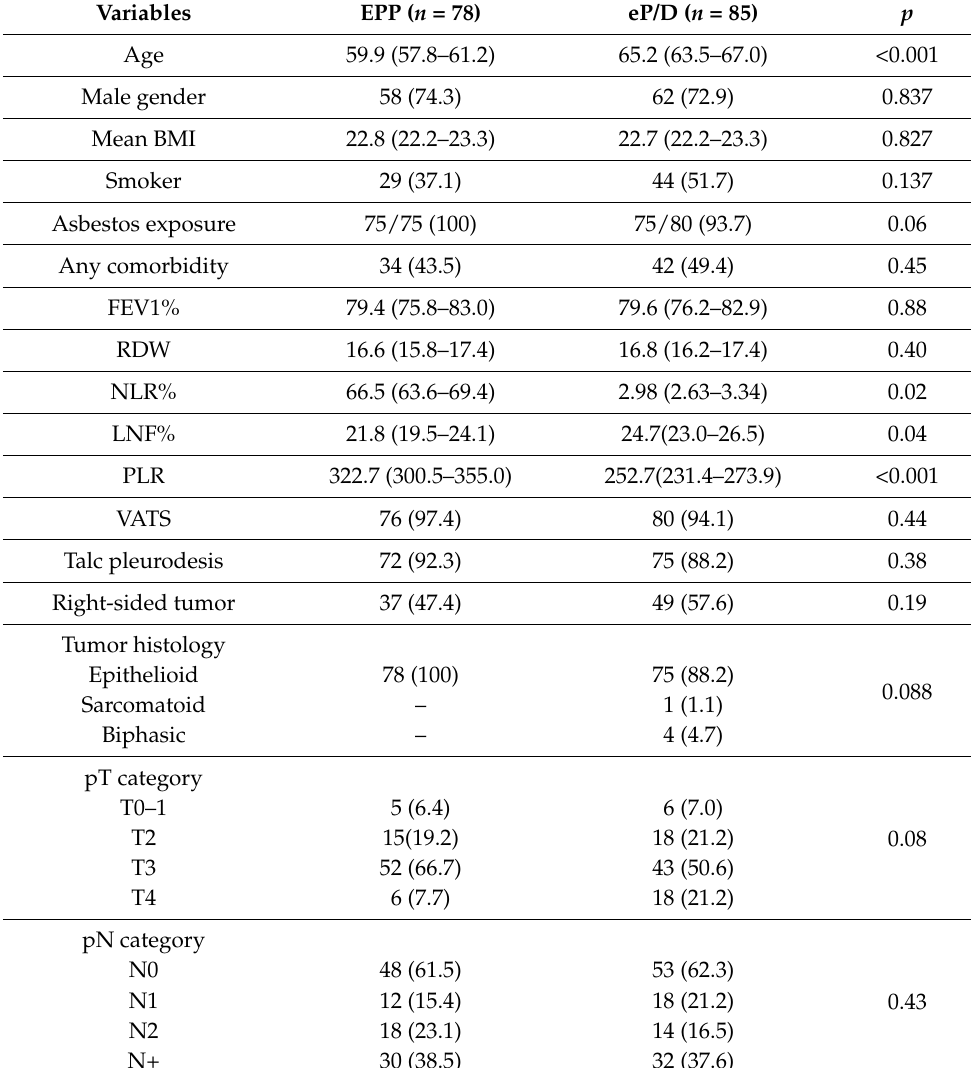
Table 1. Patients’ clinical and pathological